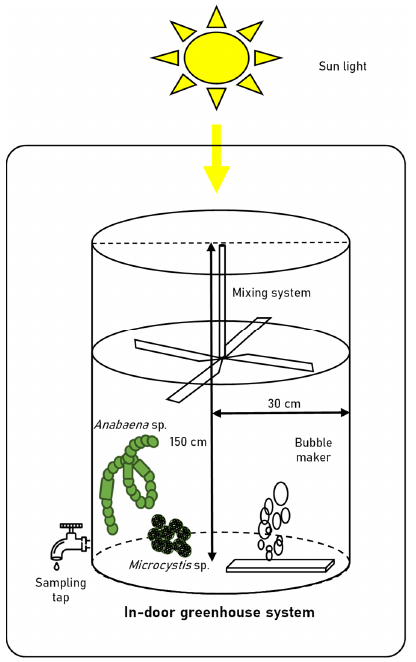
Figure 1. Schematic diagram of large-scale cultivation